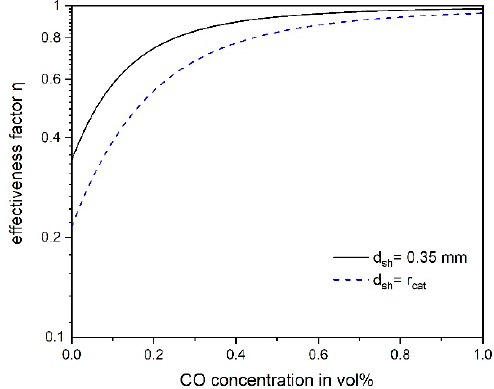
Figure 6. Influence of CO concentration on the effectiveness factor with regard to pore diffusion of CO methanation for a “full” and the egg shell catalyst used in this work (200 °C, 55% H 2 , 1 bar).